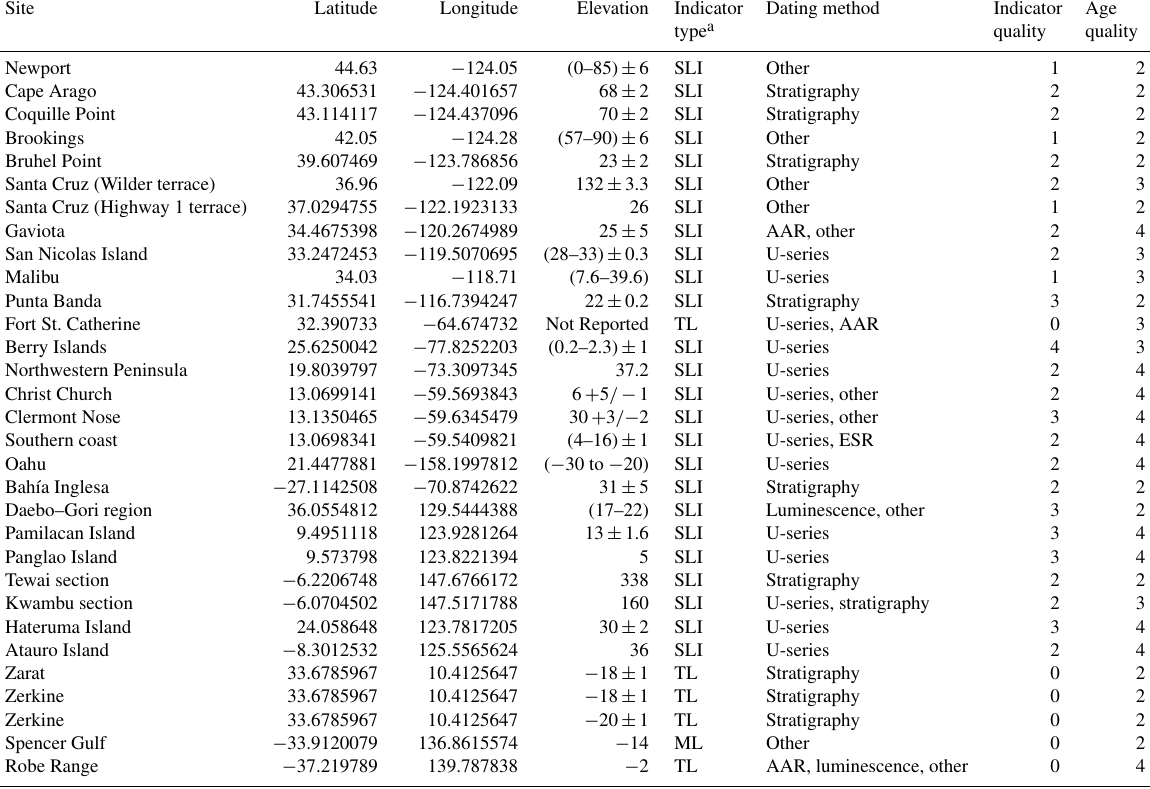
Table 2. Marine isotope stage